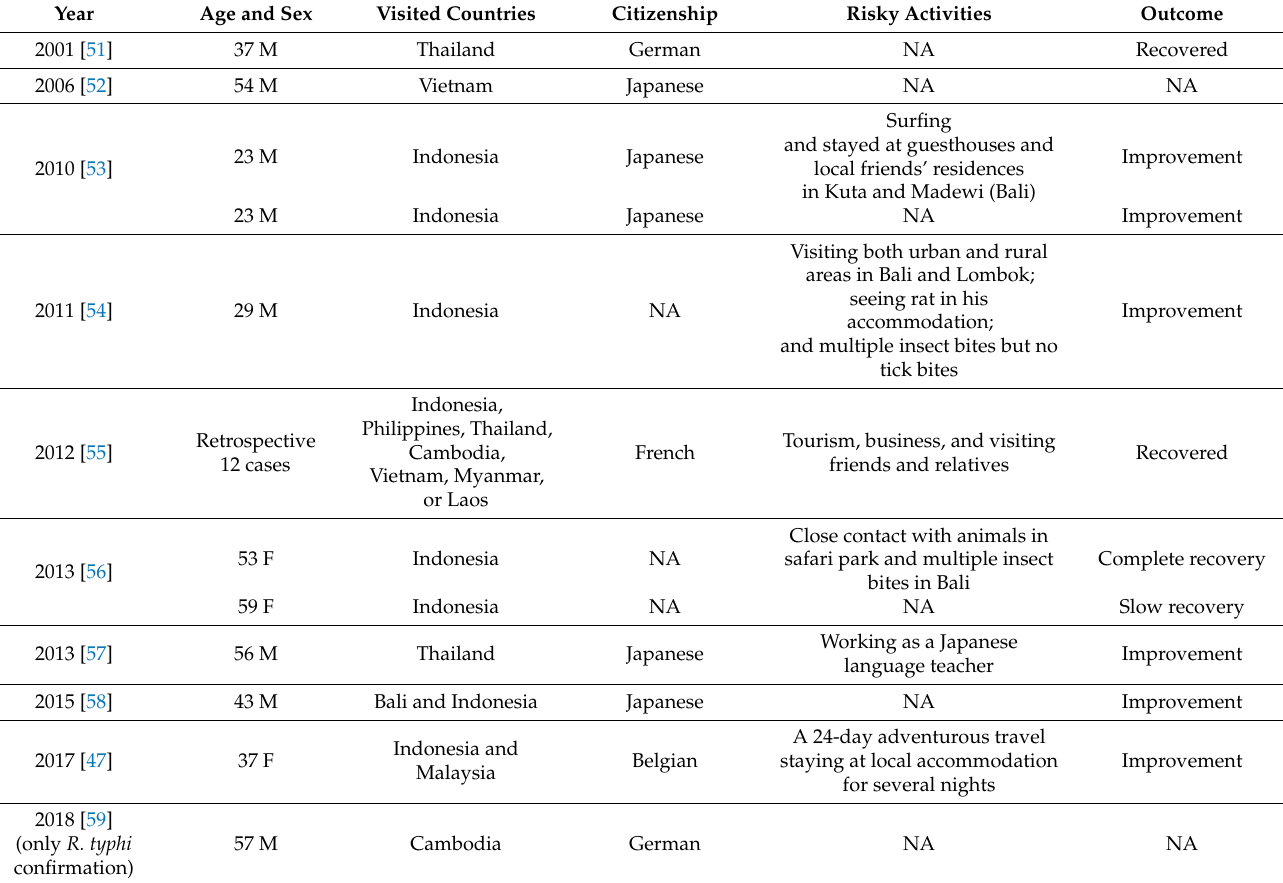
Table 2. Demographic and epidemiologic features of international travellers diagnosed with murine typhus in Southeast Asia,